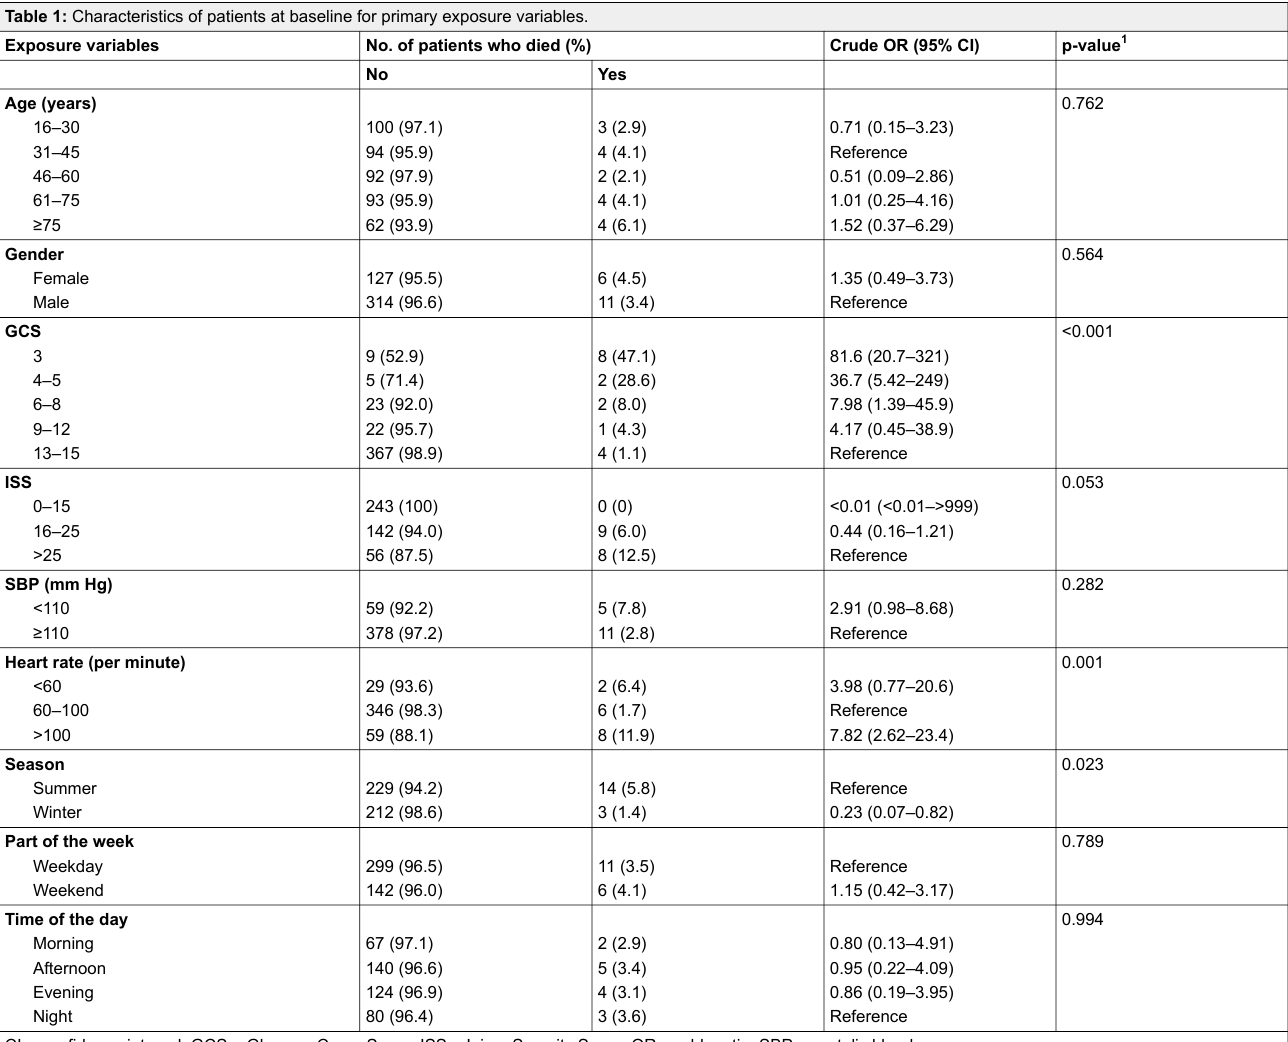
Table 1: Characteristics of patients at baseline for primary exposure variables. Exposure